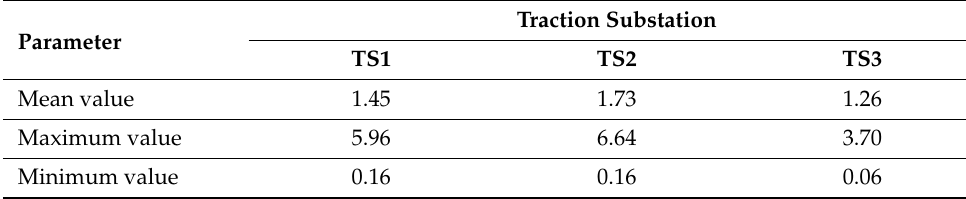
Table 6. The results of calculation of unbalance parameters at 6 kV busbars of the TS.